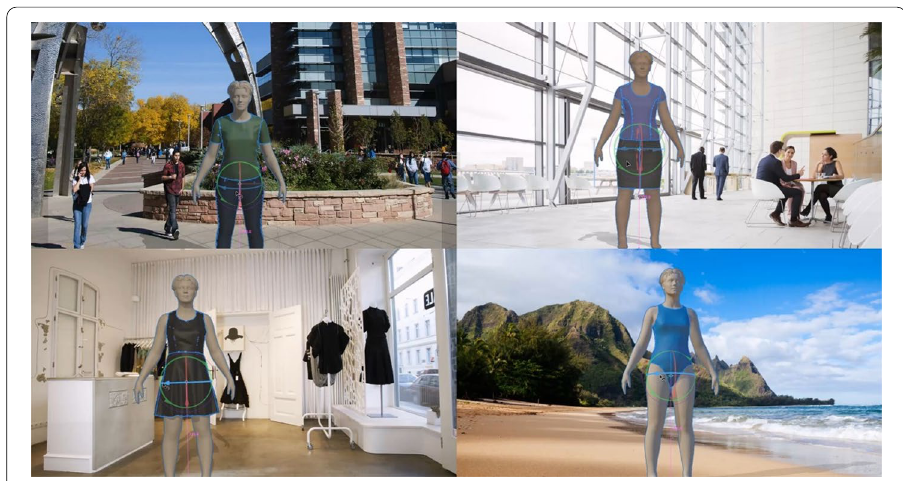
Fig. 2 Visual stimuli of virtual